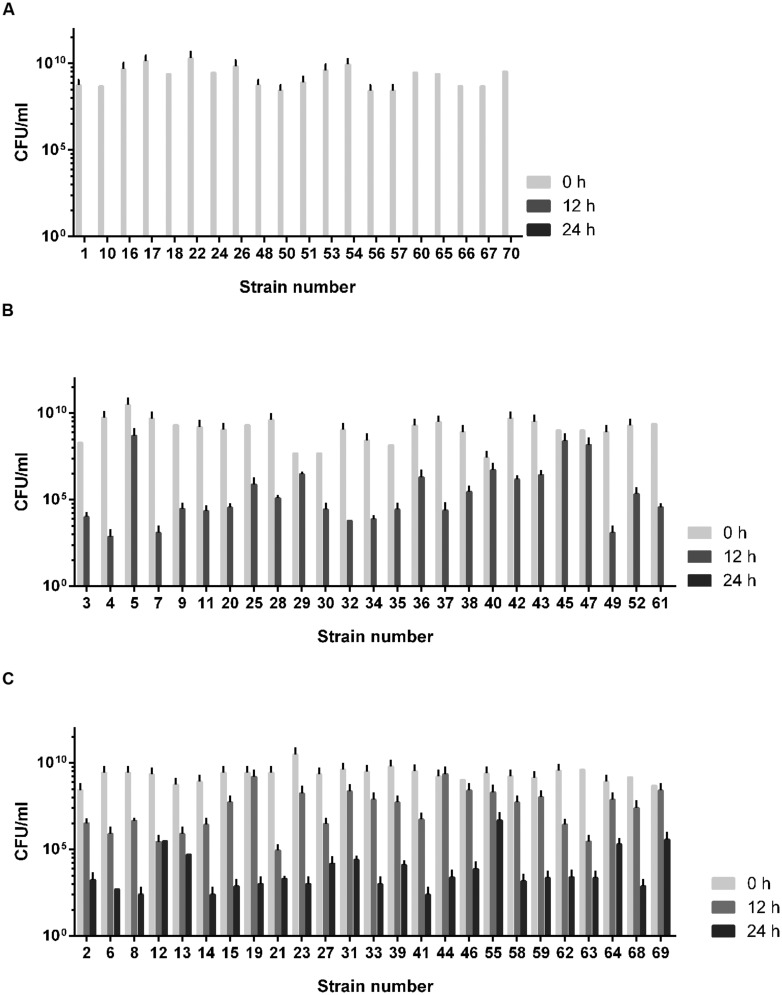
The aerotolerance levels of Campylobacter jejuni isolates from raw chicken meats. (A) Aerosensitive strains lost the viability prior to 12 h of aerobic shaking. (B) Aerotolerant strains maintained viability 12∼24 h of aerobic shaking. (C) Hyper-aerotolerant strains remained viable after 24 h of aerobic ∼shaking at 200 rpm. The results show the means and standard deviations of three different experiments. The aerotolerance tests were repeated at least three times, and similar results were observed in all the experiments.